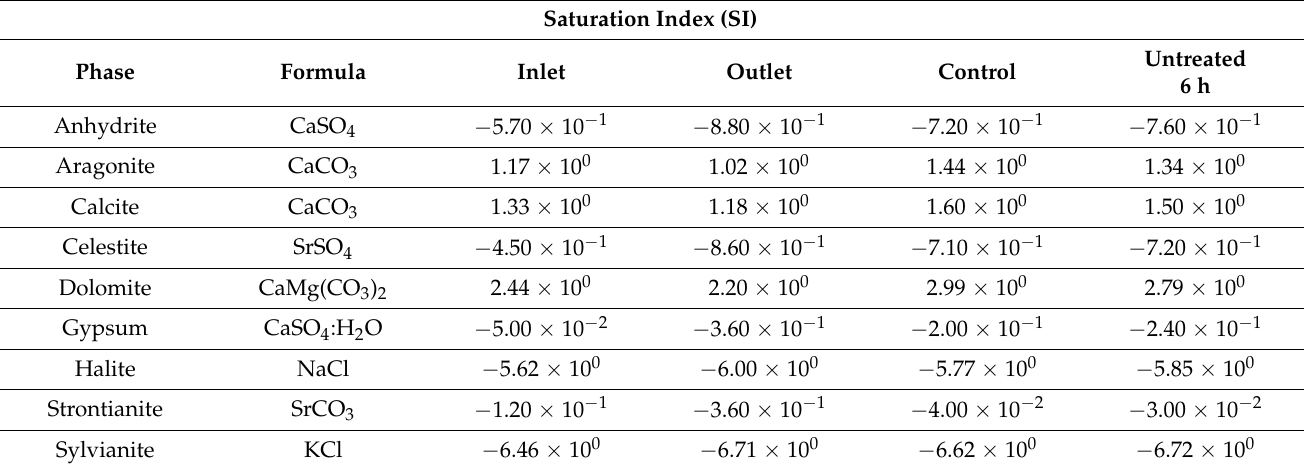
Table 4. Saturation Index values for WTP wastewater quality at two holding pond sampling locations (inlet and outlet) and for raw water control and untreated pyrolusite laboratory experiment samples. Saturation Index